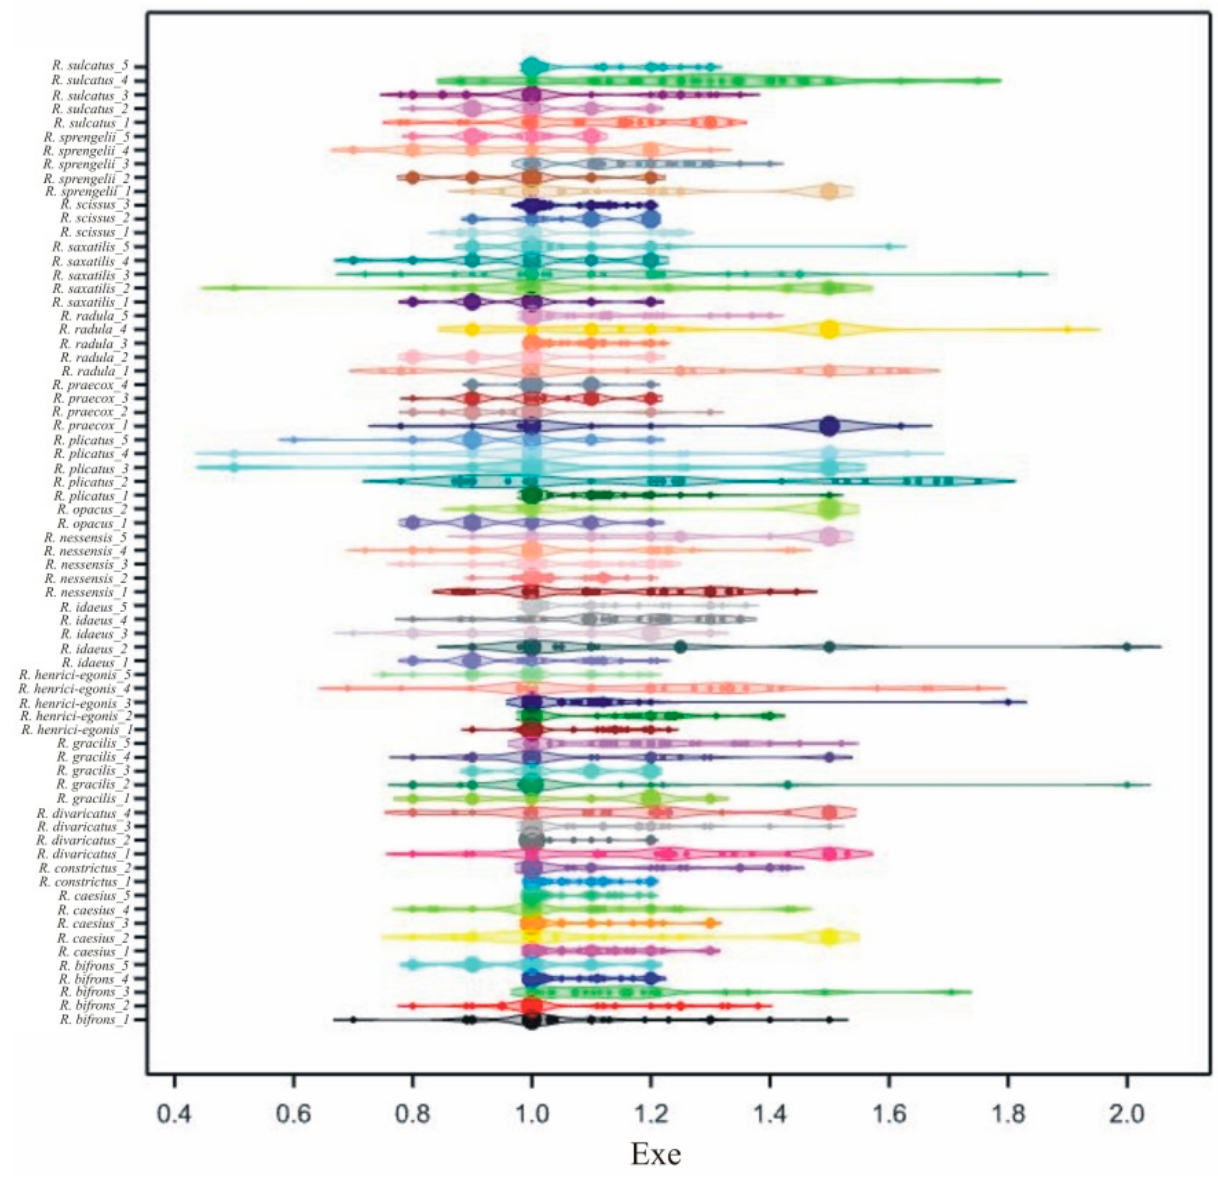
Figure 2. The density plot of Exe trait for Rubus species. The point “ • ” indicates trait observation for individual species.